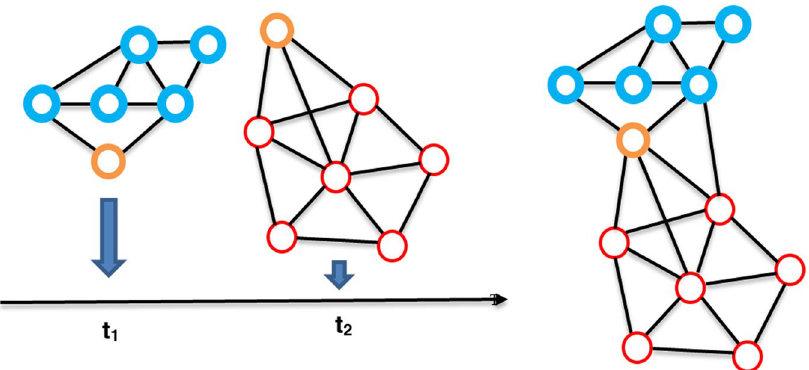
Figure 7. Effect of eliminating occurrence time of different interactions. The probability of creating wrong dense subgraph and hub vertices are increased when the time is not considered. The orange node is a sample that shows this situation. This normal node is a member of two dense complexes while it changes to a hub and a member of a larger subgraph in PPI